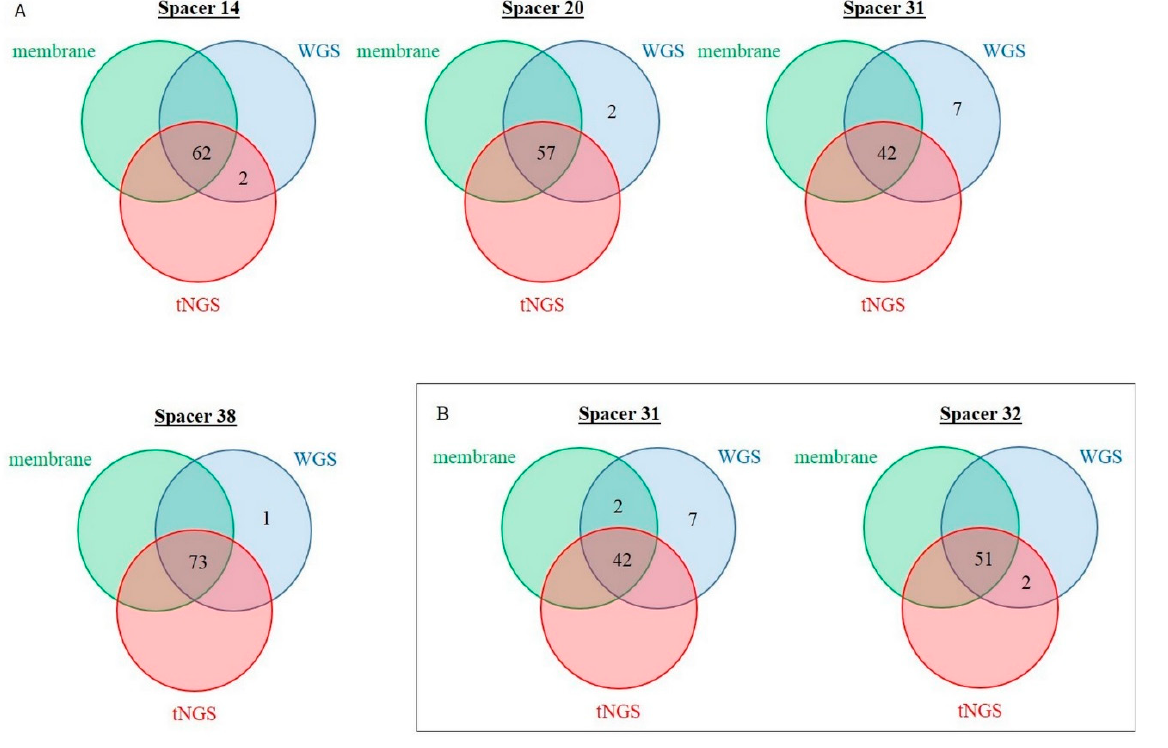
Figure 5. Representation of “present” discordant spacers using Venn diagrams for membrane- (green), targeted-next generation sequencing (tNGS; red), and whole genome sequencing (WGS; blue) based spoligotyping: ( A ) For the training set, ( B ) for the validation set.